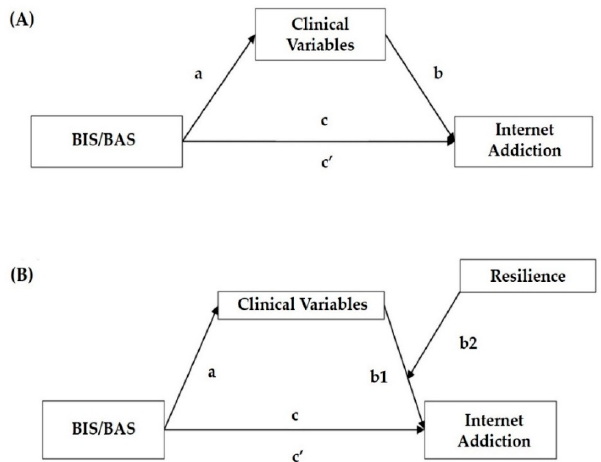
Table 3. Regression results for simple mediation in boys.